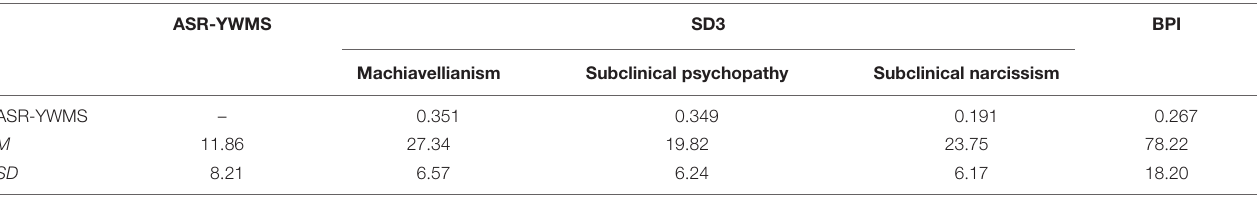
TABLE 2 | Association between acceptance of sugar relationships and socially aversive personality traits; results of Pearson’s correlations and means and standard deviations of the measured